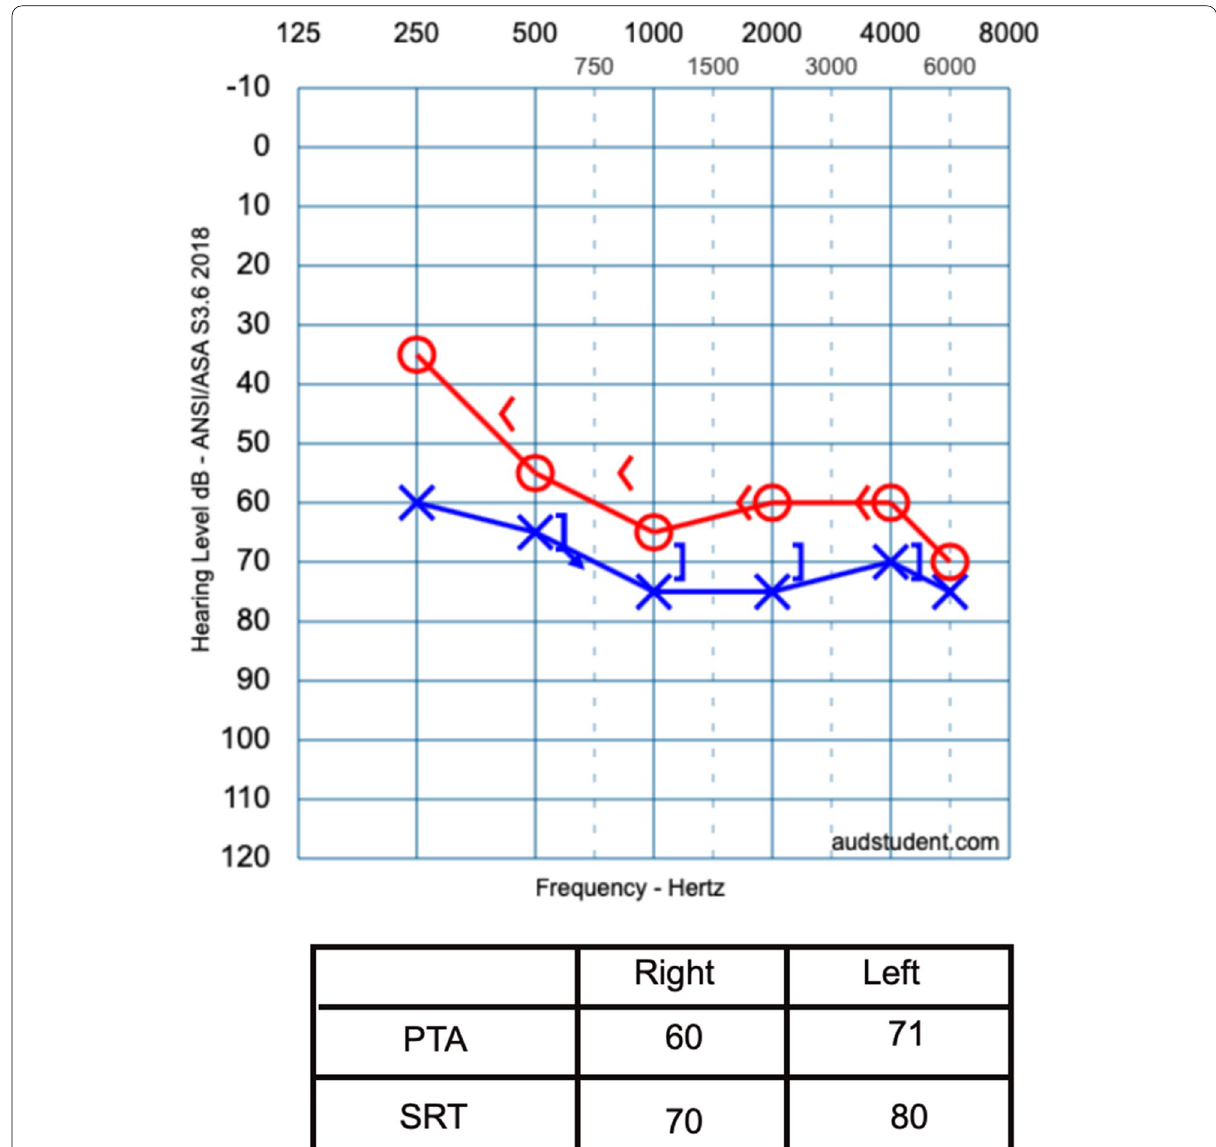
Fig. 5 The result of the repeated pure tone audiometry performed at our clinic on February 10,